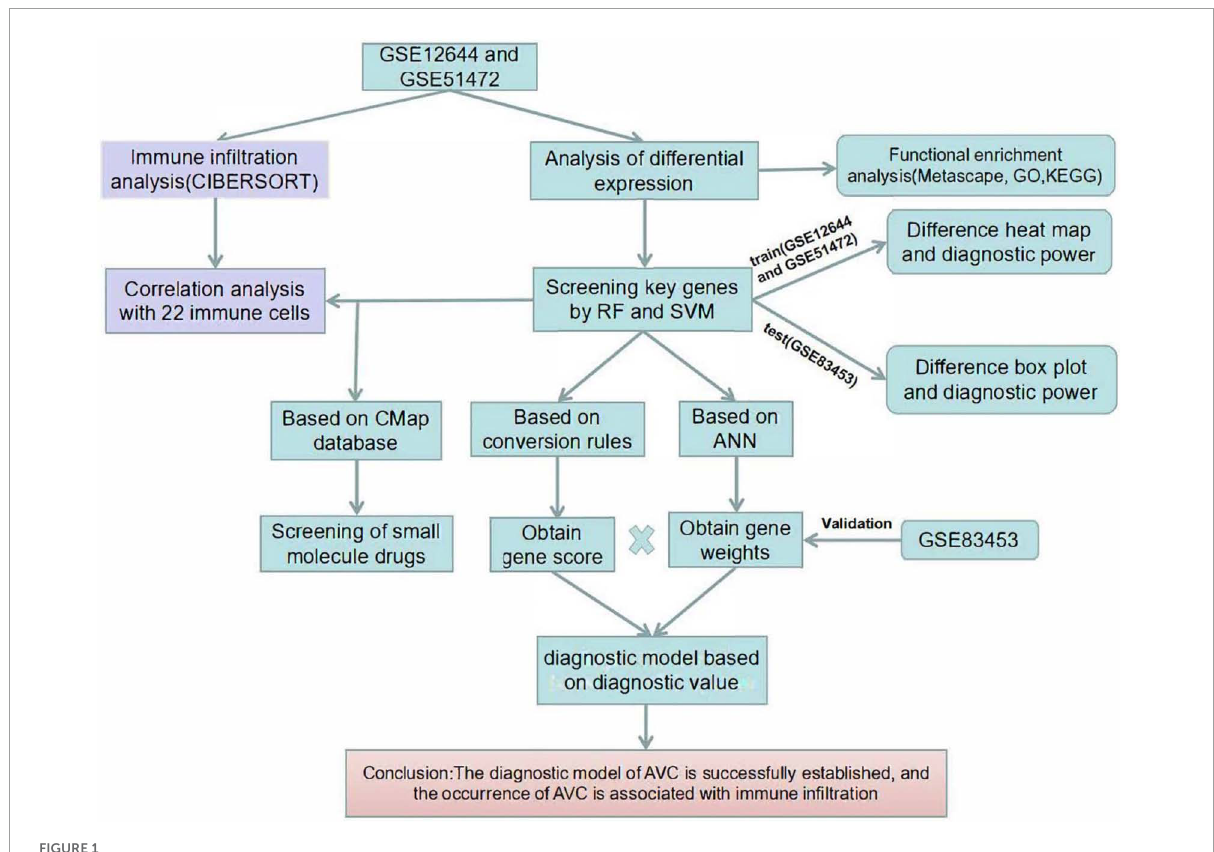
FIGURE1 Flow chart of the research